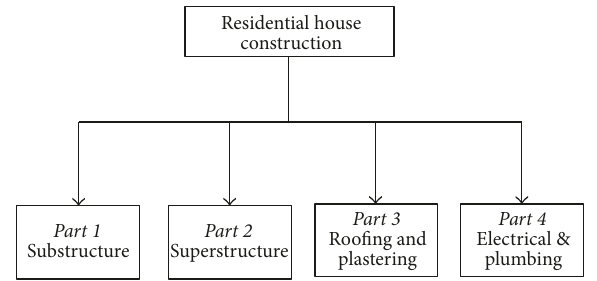
Figure 2: Work Breakdown Structure for a residential